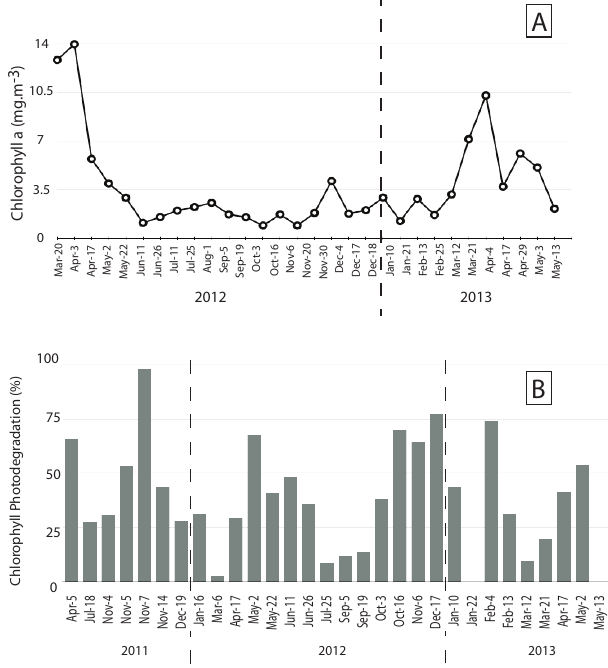
Figure 4. Chlorophyll a levels (MOOSE data) and percentage of photodegradation of chlorophyll, calculated using CPPI (Cuny et al., 1999) in the Rhône waters on and around sample